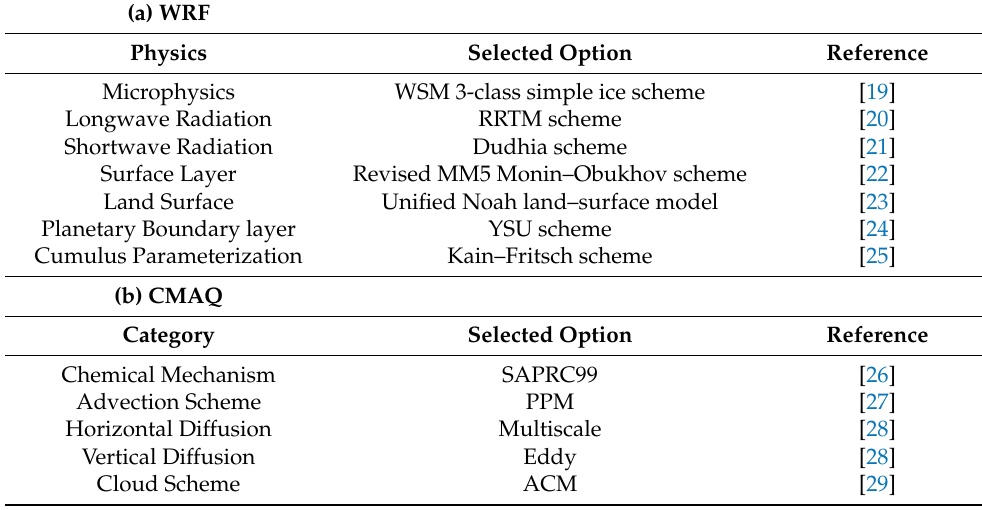
Figure 1. Modeling domains for air quality simulation. Table 1. Summary of WRF and CMAQ configuration.